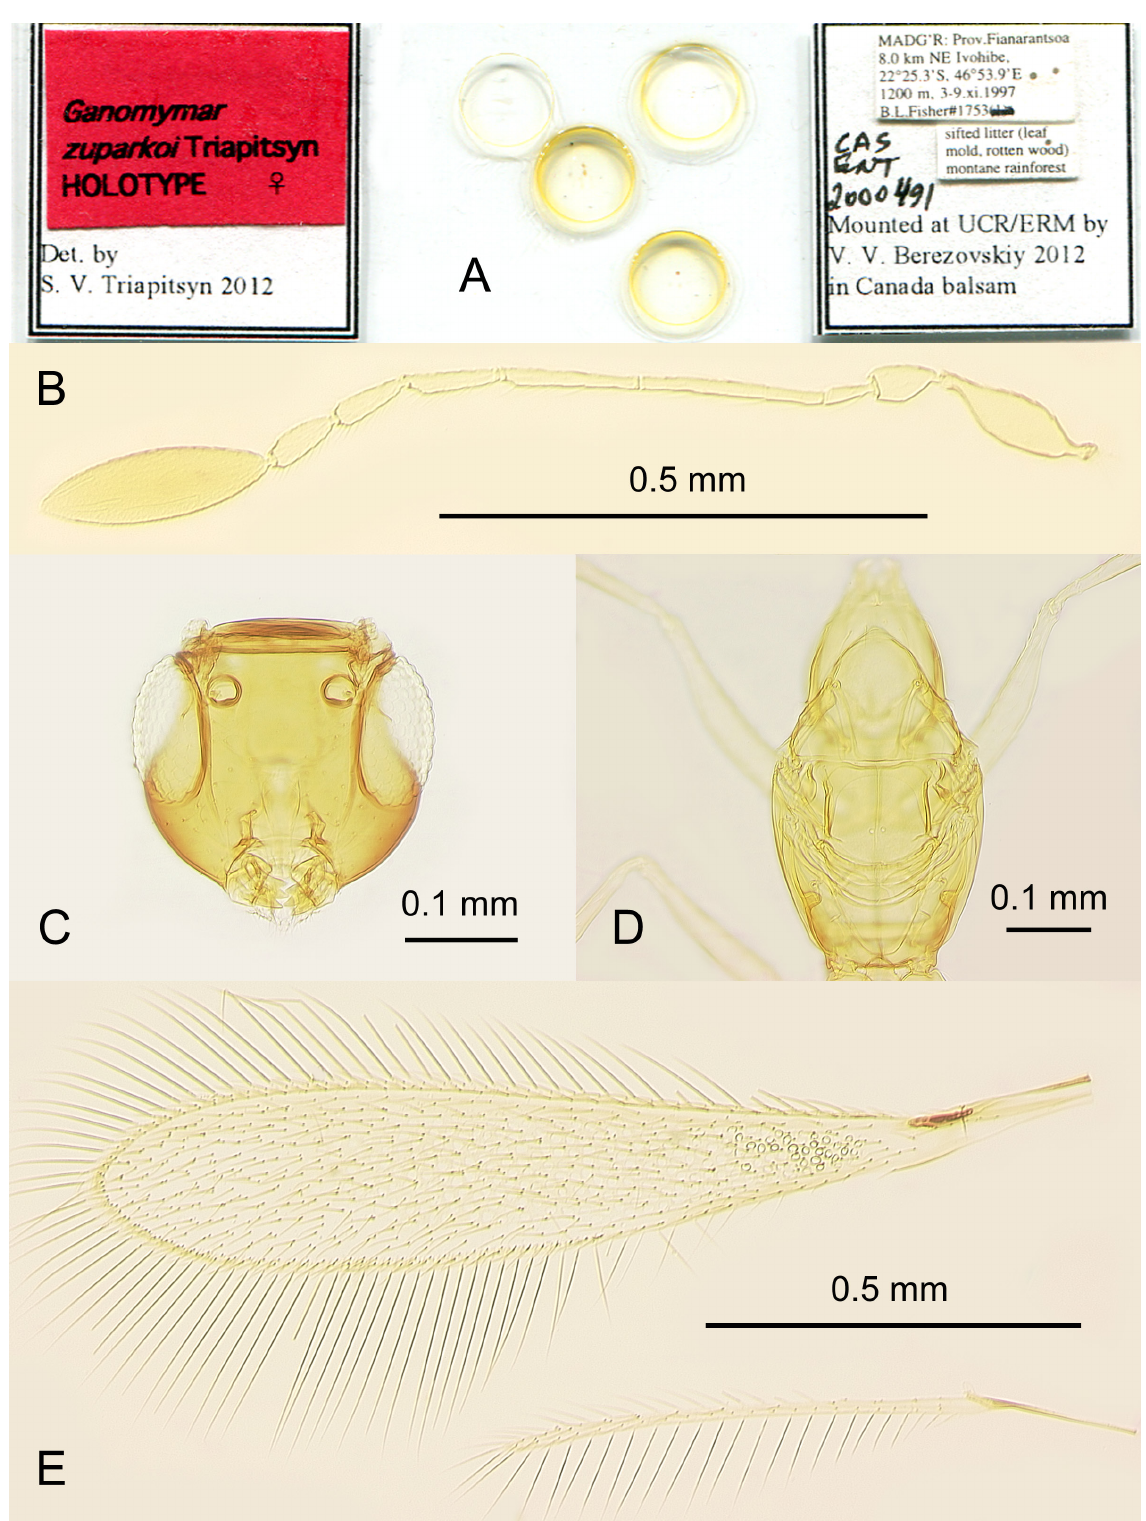
Fig. 14. Ganomymar zuparkoi sp. nov., ♀, holotype (CAS). A . Slide. B . Antenna. C . Head in frontal view. D . Mesosoma. E . Fore and hind